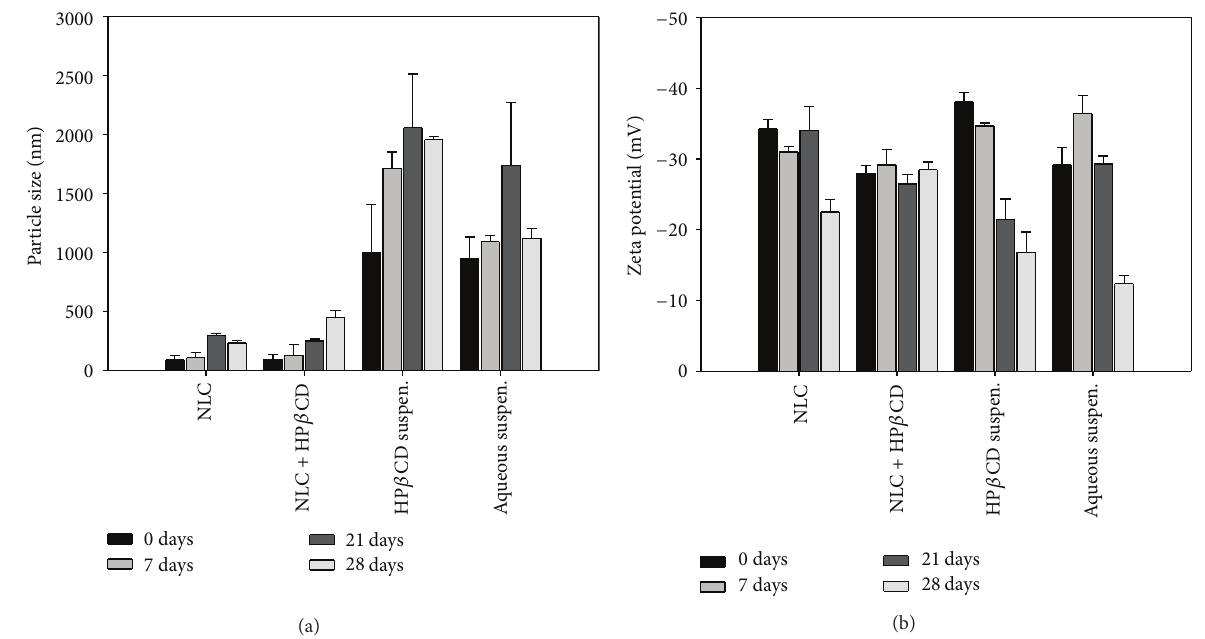
Figure 4: Size stability and zeta potential of lutein loaded vehicles after one month storage, 𝑛 = 3 .